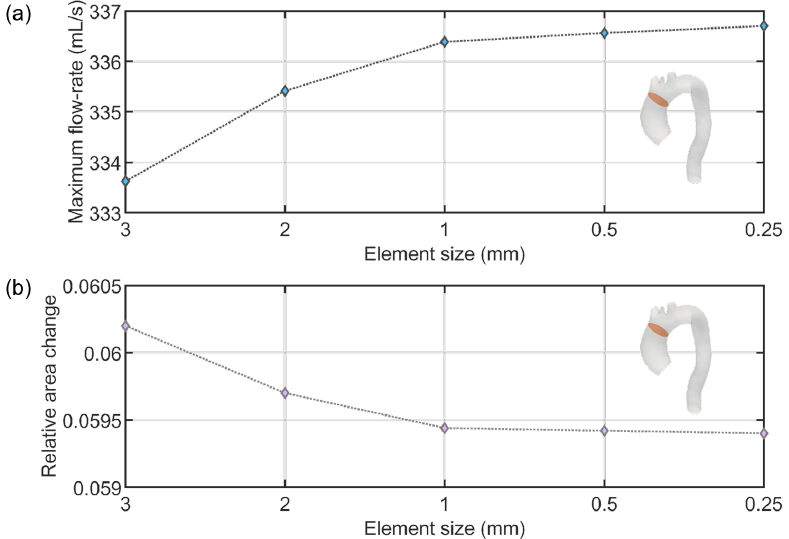
Figure A1. Mesh sensitivity analyses of five meshes (3, 2, 1, 0.5, and 0.25 mm) conducted on relative area change ( a ) and maximum flow rate ( b ) measured at a specific model’s